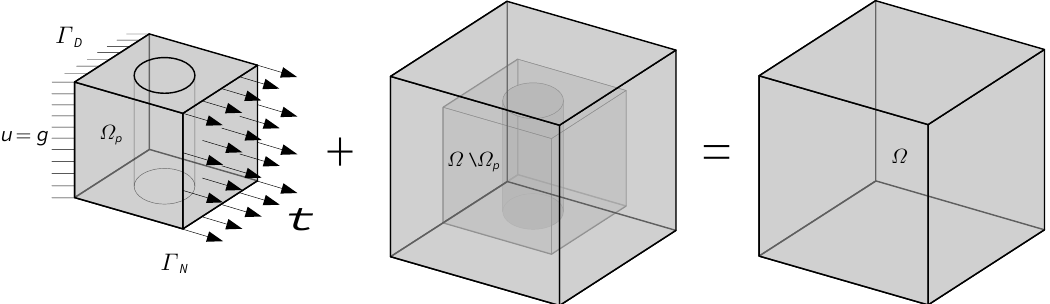
Figure 3. The original physical domain Ω p is extended to the embedded domain Ω Figure 3. The original physical domain p  is extended to the embedded domain  . Figure 3. The original physical domain p W is extended to the embedded domain W . The strong form of the boundary value problem for embedded domain  can be expressed as